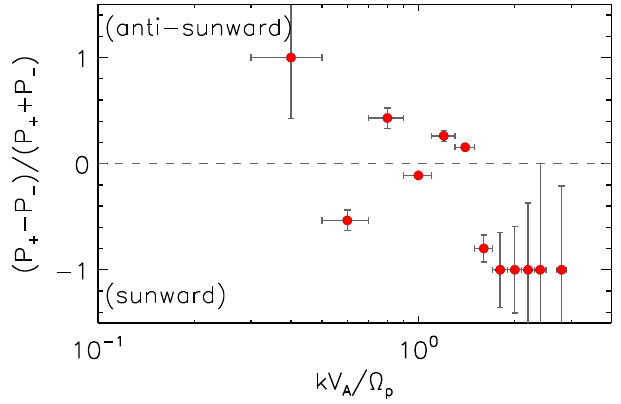
Fig. 5. Power ratio between sunward and anti-sunward propagating Figure 5: Power ratio between sunward and anti-sunward propagating waves.